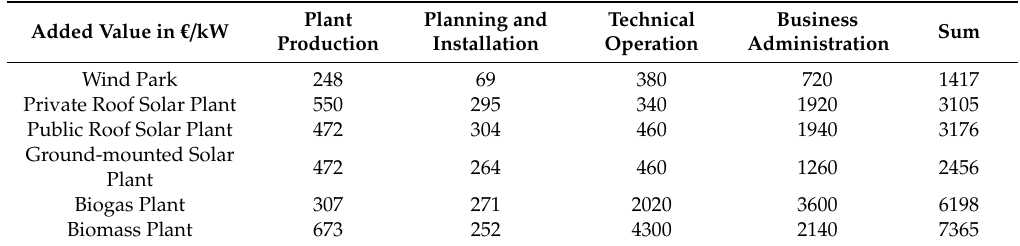
Table 3. Municipal value-added e ff ects over a period of 20 years (according to [36]).